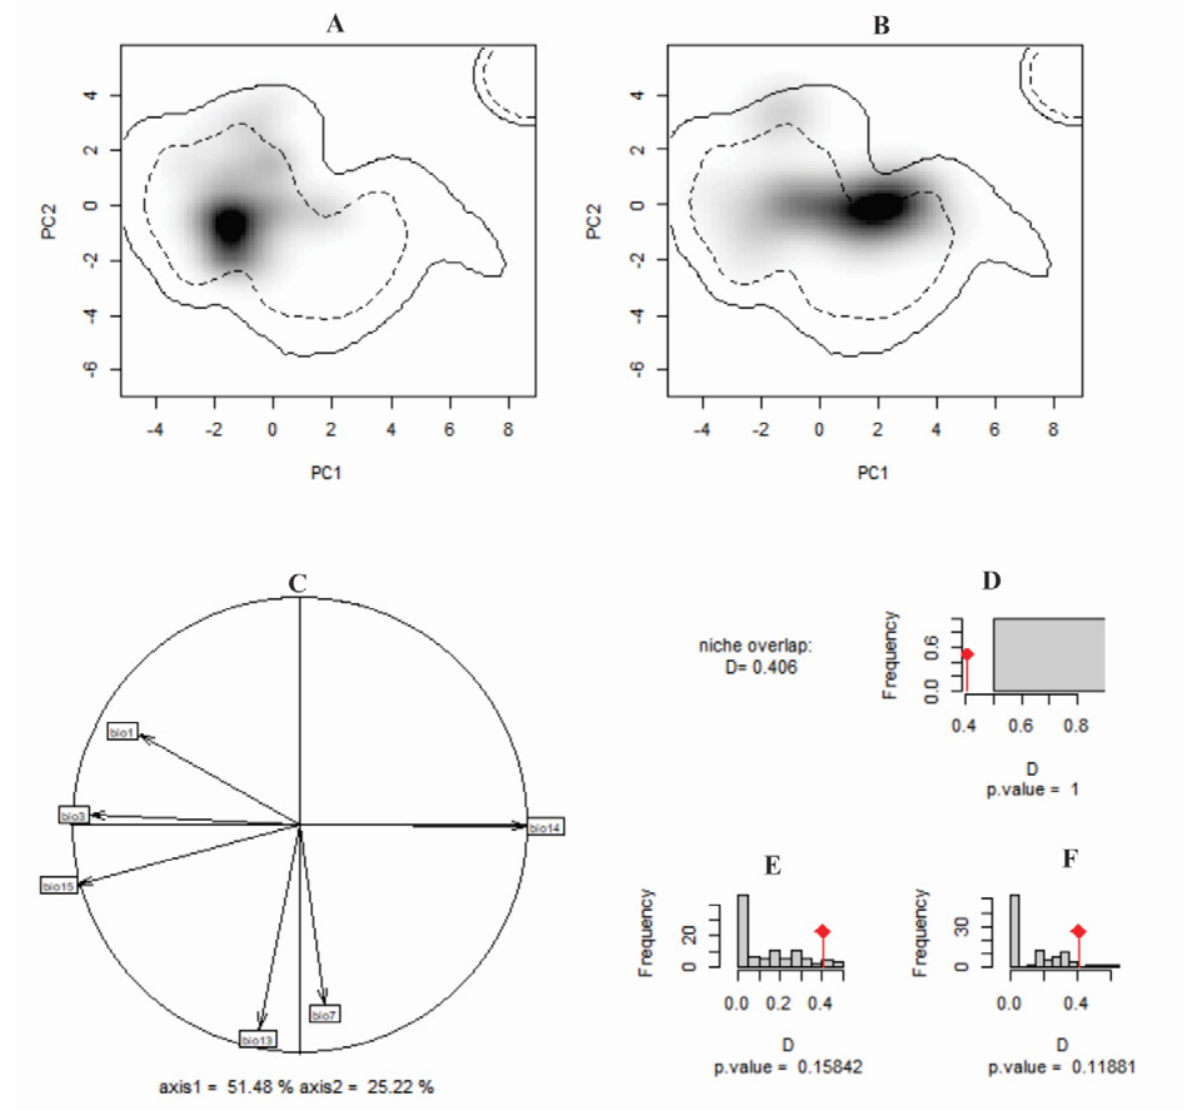
Fig 4 . Future climatic niches occupied by the two subspecies of Melipona quadrifasciata. Niche occupied by M. q. anthidioides (A) and M. q. quadrifasciata (B) along the two-first axes of the PCA (see (C) for details). Grey shading represents the density of the occurrences of the subspecies by cell. The solid and dashed contour lines illustrate, respectively, 100% and 50% of the available (background) environment. (C) Contribution of the climate variables to the first-two axes of the PCA (bio1: annual mean temperature, bio3: isothermality, bio7: annual temperature rate, bio13: precipitation of the wettest month, bio14: precipitation of the driest month, and bio15: precipitation seasonality), and contribution of the two-first axes to data variation. (D) Histogram of the observed niche overlap D (D = 0.406) (bars with a diamond) and simulated niche overlaps (grey bars). (E) Niche similarity of M. q. quadrifasciata to M. q. anthidioides , and (F) niche similarity of M. q. anthidioides to M. q. quadrifasciata